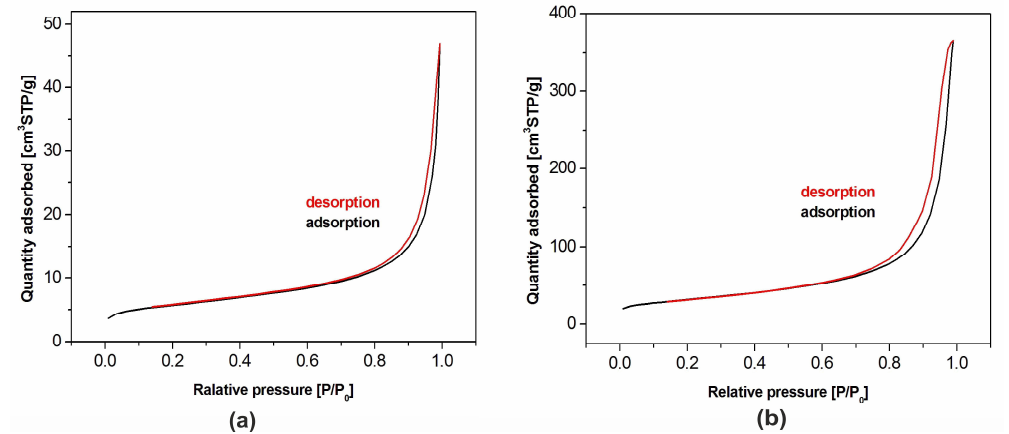
Figure 4. Nitrogen adsorption-desorption isotherms for HAp powders of: ( a ) Nanosize particles and ( b ) microsize particles.